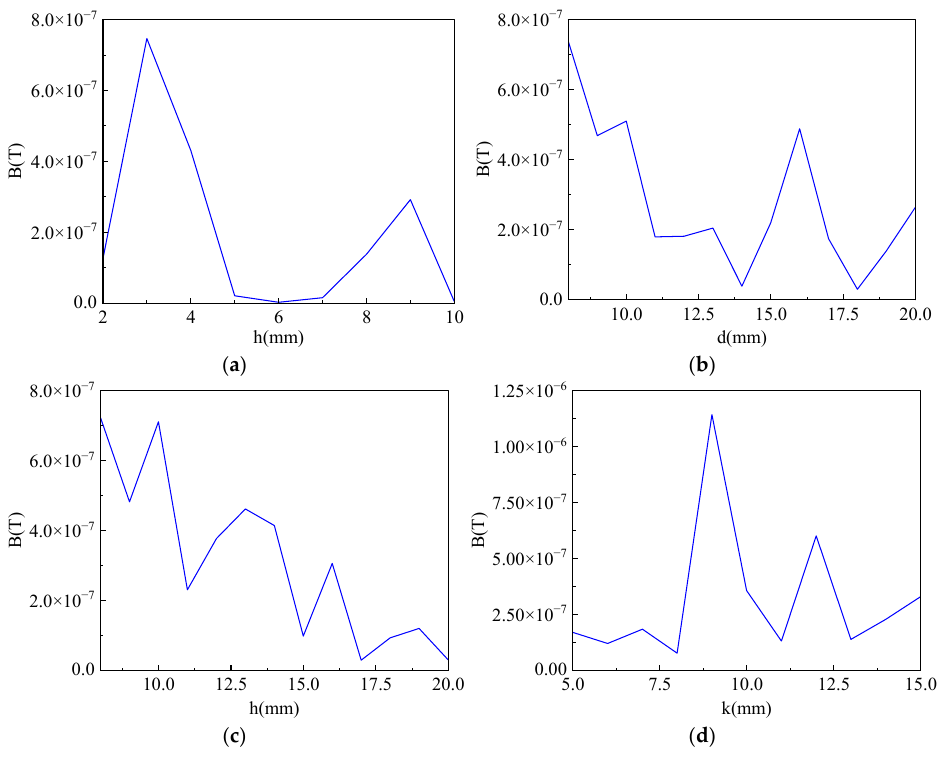
Figure 3. Parametric sweep results of the magnetic concentrating ring size. ( a ) the height; ( b ) the air gap width; ( c ) the inner radius; and ( d ) the thickness. When the height of the magnetic ring changes, the magnetic flux density at the center of the air gap fluctuates, and the value of the average magnetic induction intensity de- tected first increases slightly and then begins to gradually decrease. This is because the magnetic field sensor is always 1 mm from the bottom of the magnetic ring, and the open- ing edge of the magnetic ring will have some magnetic leakage. When the height of the magnetic ring increases, the magnetic field sensor is farther away from the opening edge of the magnetic ring, so the average magnetic induction intensity increases slightly. How- ever, as the height of the magnet increases, the opening area and magnetic leakage will gradually increase. Therefore, according to the change curve, the height of the magnetic concentrating ring is set to 3 mm.